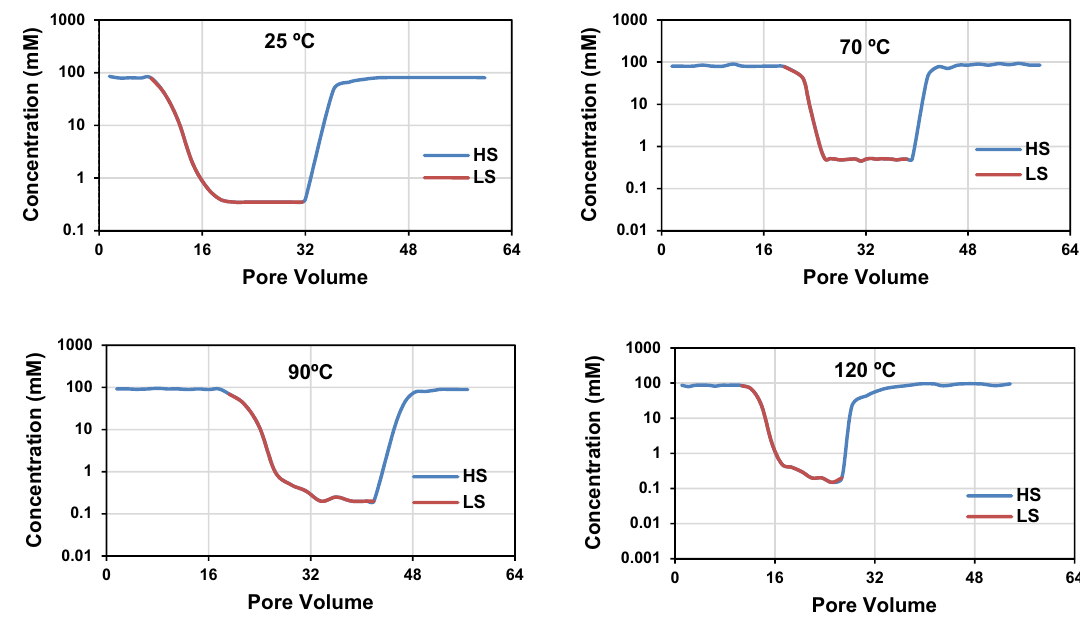
Fig. 11 Effluent concentrations of Ca 2+ from sandstone column#2 (sand + kaolinite), at 25, 70, 90, and 120 °C